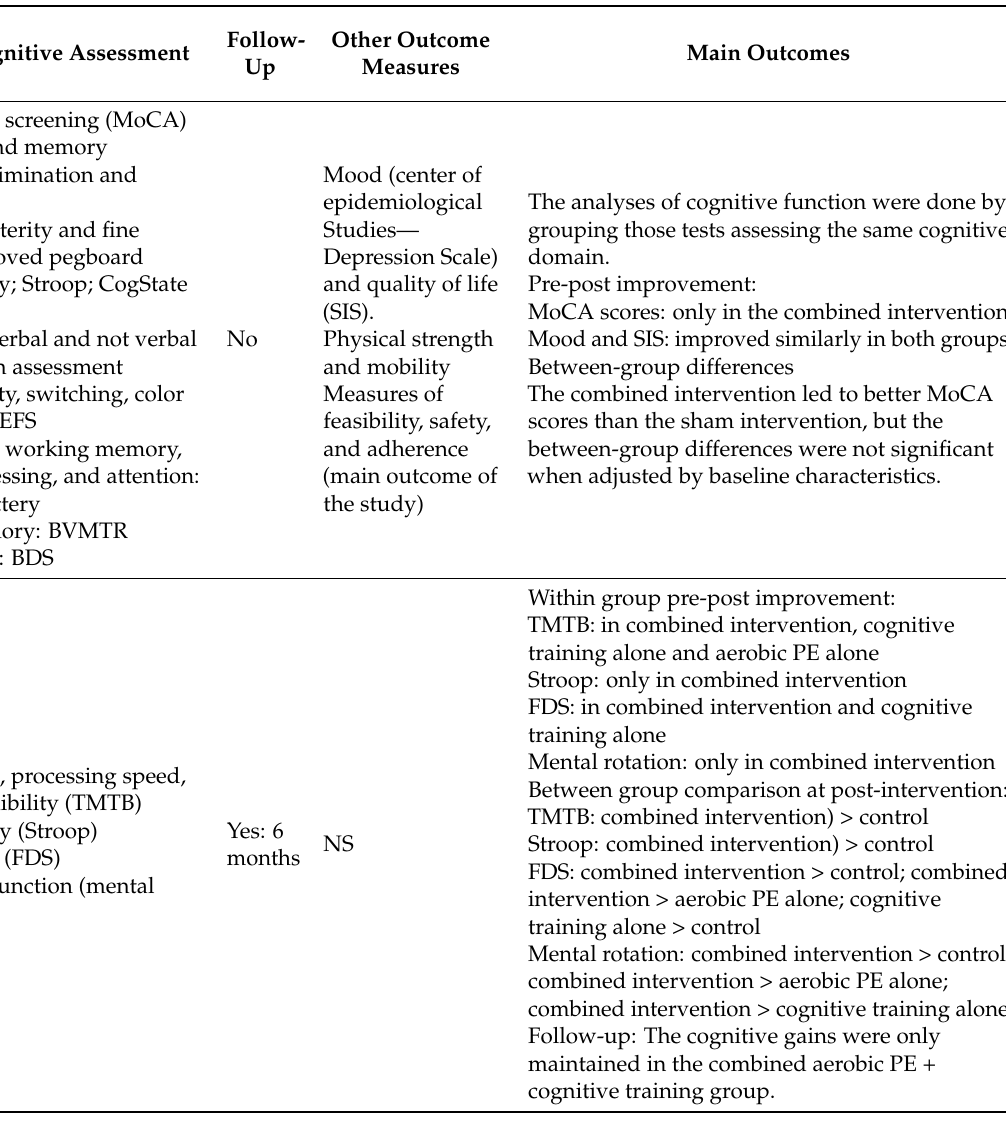
Table 2. Experimental conditions, characteristics of the interventions, and main outcomes obtained in the revised